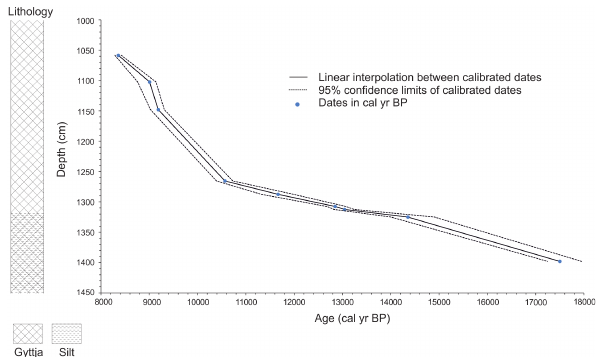
Fig. 2. Age-depth model of the Origlio record including litholog- ical description of the sediments. AMS 14 C ages were obtained from 9 plant macrofossils (see Table 1). The 14 C dates were cal- ibrated (calyrBP) with the program Calib version 6.0 (Reimer et al., 2004) using the IntCal09 dataset (Heaton et al., 2009). The age- depth model is based on linear